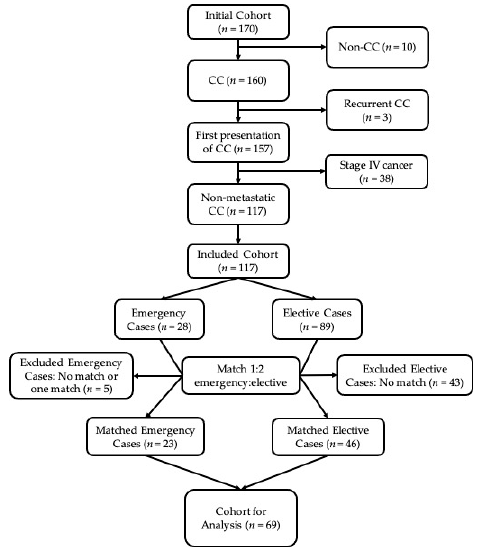
Figure 1. Cohort build. CC = colon